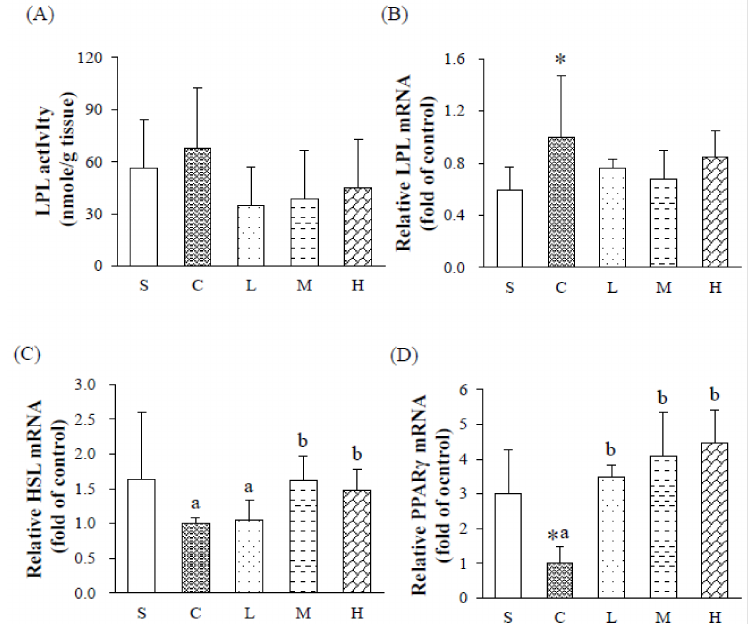
Figure 3. Adipose tissue lipid metabolism variables after 8 weeks of a dietary intervention. ( A ) Adi- pose tissue lipoprotein lipase (LPL) activity, ( B ) relative LPL mRNA, ( C ) relative hormone-sensitive lipase (HSL) mRNA and ( D ) relative peroxisome proliferator-activated receptor gamma (PPAR γ ) mRNA. Results are presented as the mean ± standard deviation. * p < 0.05 vs. S; a,b p < 0.05 be- tween different superscripts. S, sham-operated group; C, control group; L, low-dosage group; M, medium-dosage group; H, high-dosage